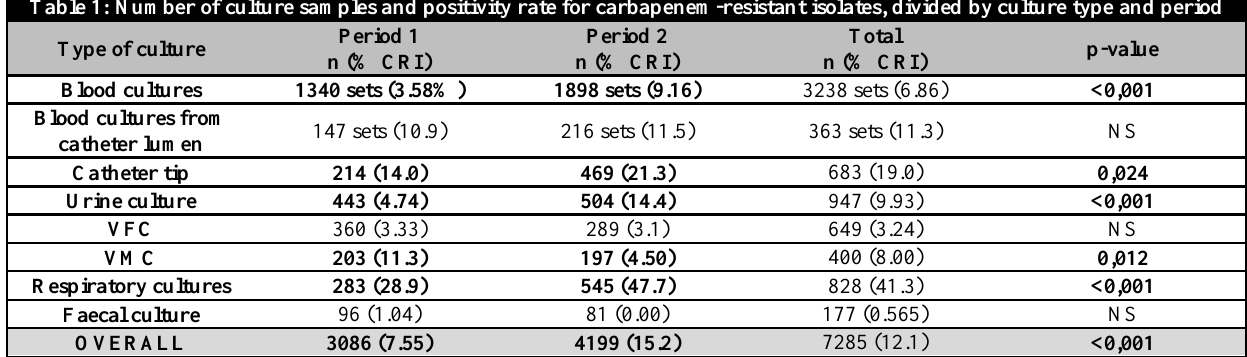
Table 1: Number of culture samples and positivity rate for carbapenem-resistant isolates, divided by culture type and period Type of culture